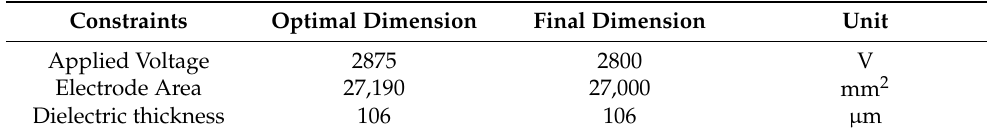
Table 7. Specification of the optimal electroadhesion pad used in the Ansys Maxwell.